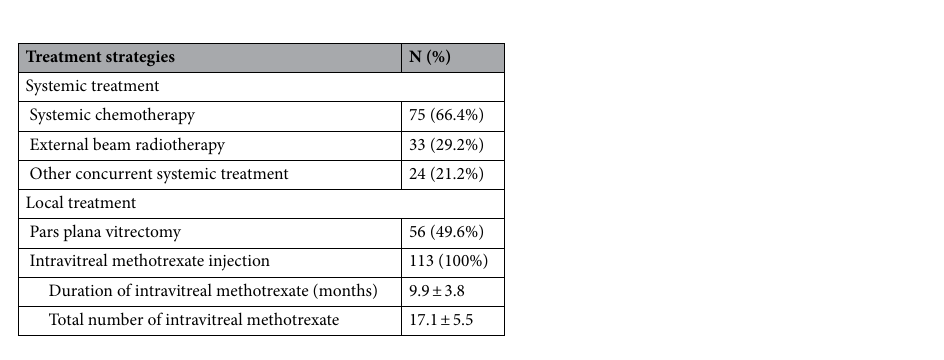
Table 3. Systemic and local treatment strategies for vitreoretinal lymphoma. Data are expressed as mean ± standard deviation (95% confidence interval).